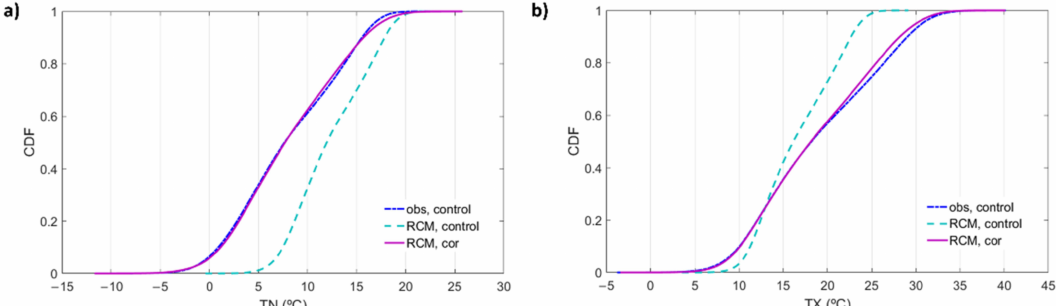
Figure 3. Cumulative distribution functions (CDFs) of the observations (obs, control), ensemble-mean simulation with no bias correction (RCM, control) and bias-corrected ensemble-mean (RCM, cor) for the baseline climate (1971–2000): ( a ) minimum, and ( b ) maximum daily temperatures ( ◦